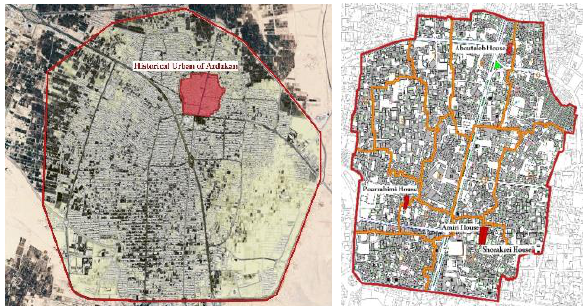
Figure 2. Location of historical urban fabric in Ardakan city; Distribution of studied Muzaffarid houses in historical urban fabric of